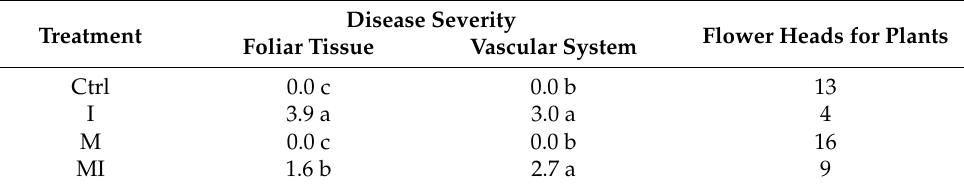
Table 1. Effectiveness of mycorrhizal fungus G. viscosum in protecting globe artichoke against Verticillium wilt. For each parameter, different letters (a,b,c) within the same column indicate that the means are significantly different at p ≤ 0.05 according to Duncan test. The experiments were repeated three times with three replicates. Ctrl, non-mycorrhizal plants; I, non-mycorrhizal plants inoculated with V. dahliae ; M, mycorrhizal plants; MI, mycorrhizal plants inoculated with V. dahlia .